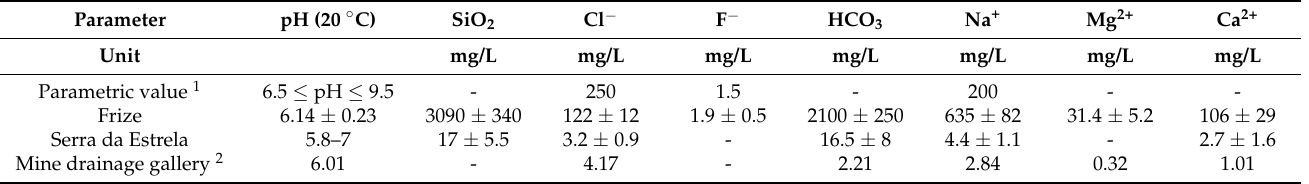
Table 1. Chemical composition of waters used in the laboratory to measure the electrical resistivity of “Frize” mineral water, “Serra da Estrela” spring water, and water from a mine drainage gallery in Regoufe.